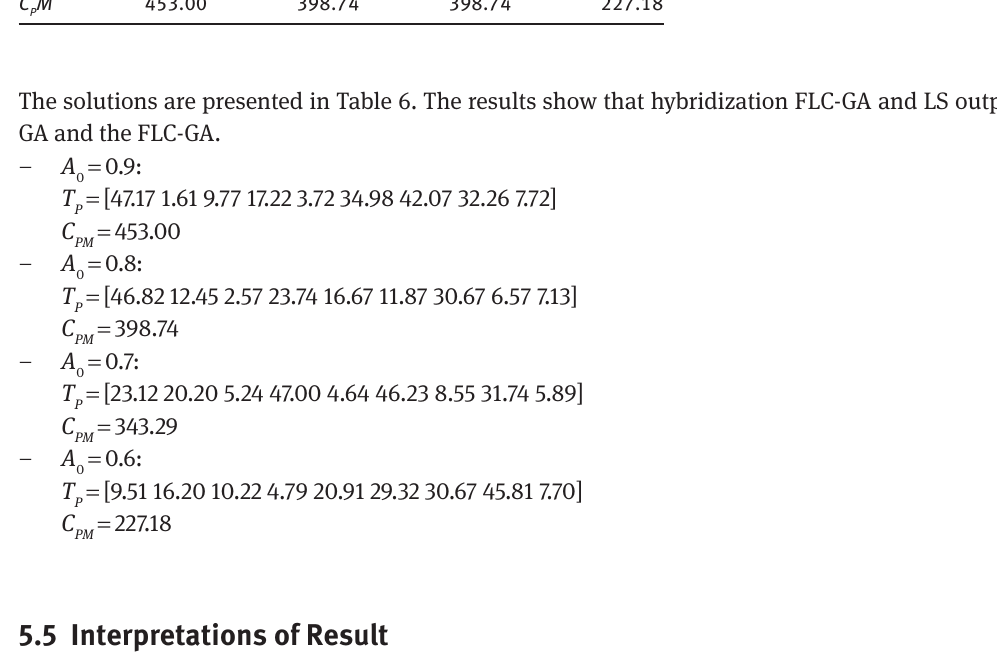
Table 6: PM Cost for Different Values of A A